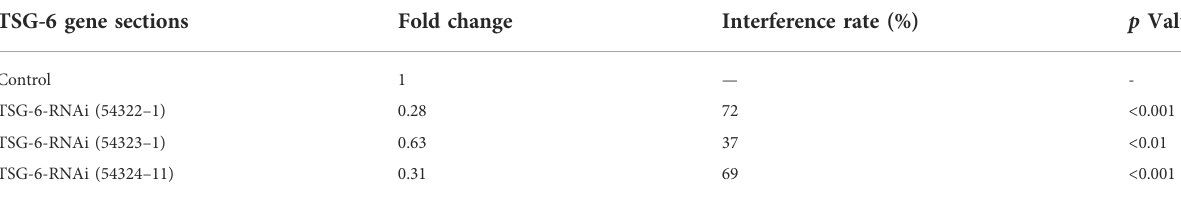
TABLE 1 Determination of the interference rate by qRT-PCR. TSG-6 gene sections Fold change Interference rate